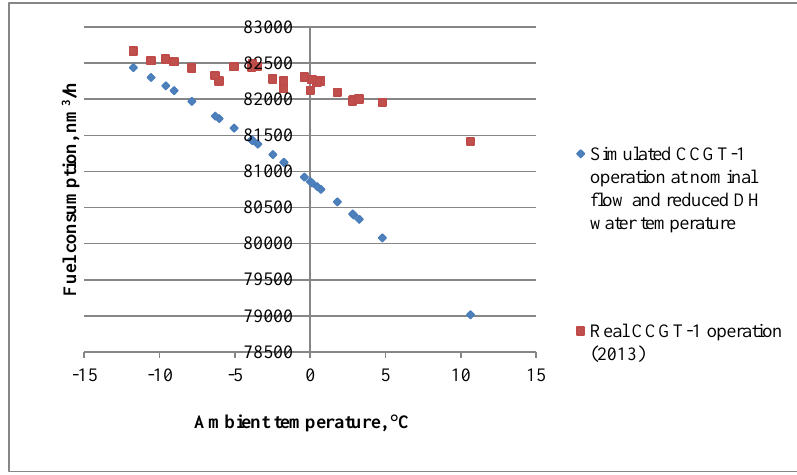
Fig. 3. Fuel consumption at actual and simulated CCGT